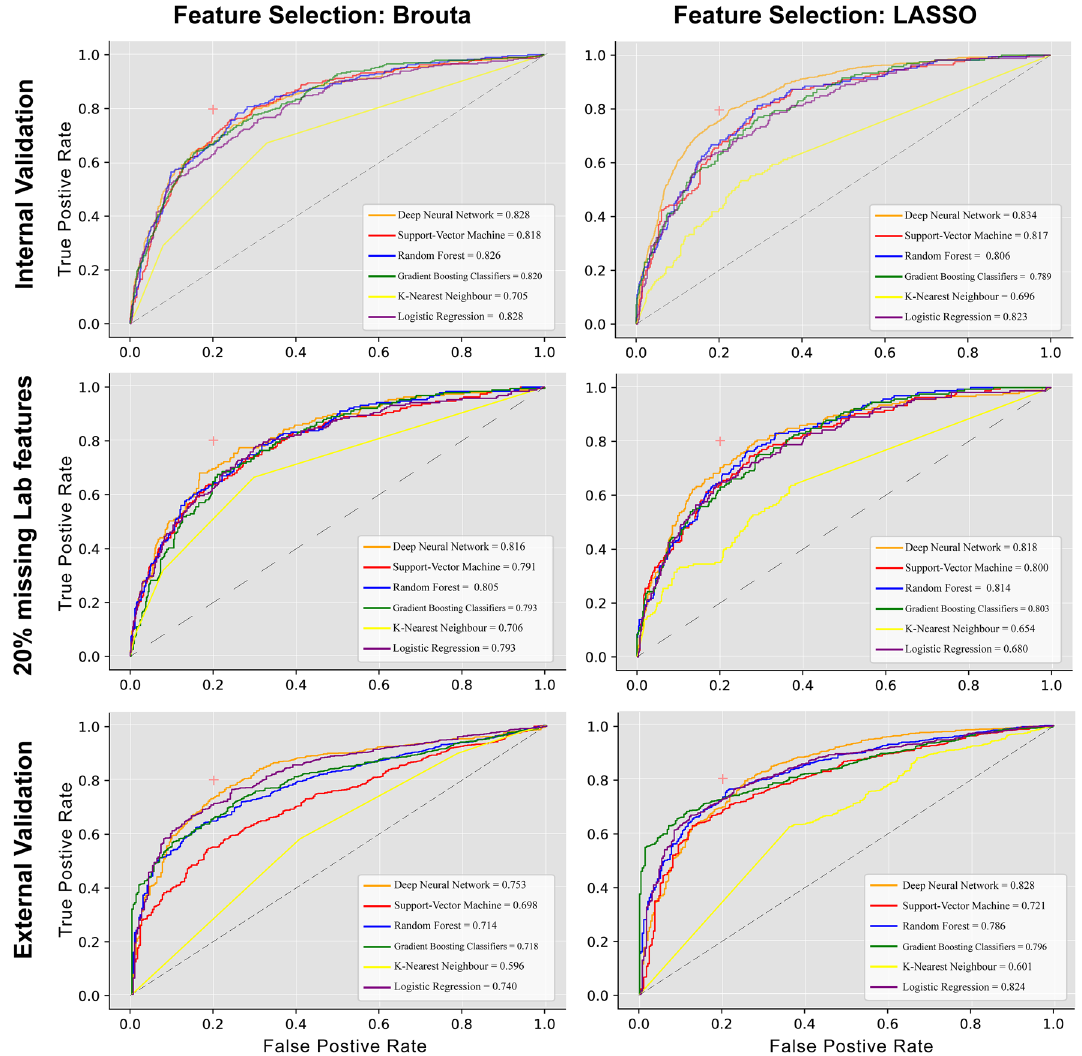
Figure 2. Receiver operator curve of models using two different feature